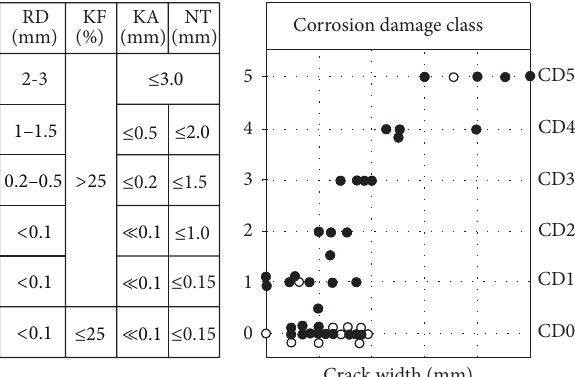
Figure 2: Degree of corrosion depending on crack width for XS3 and an exposure duration of 30 years